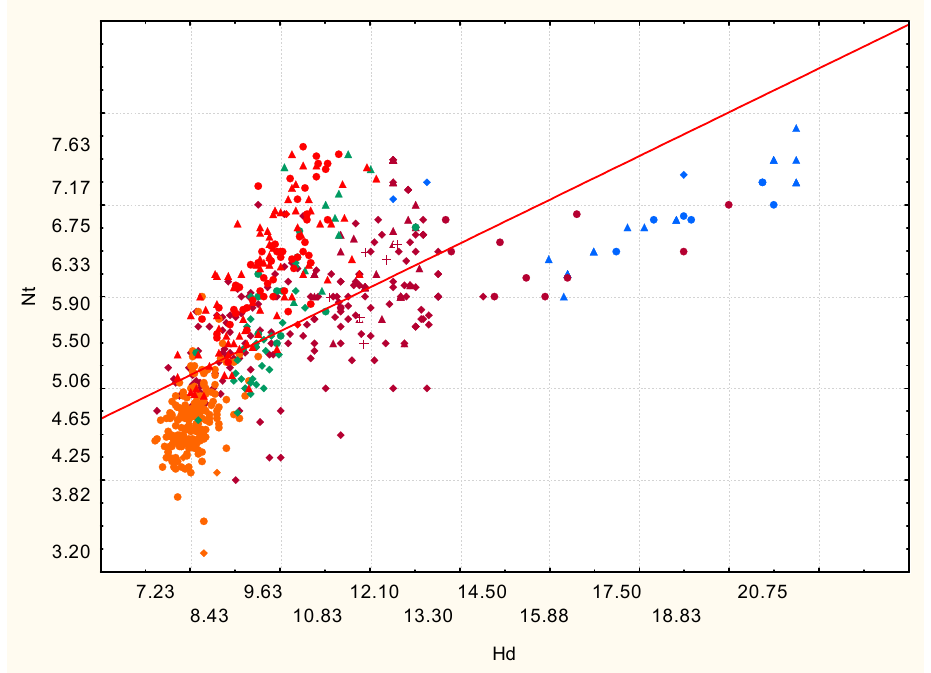
Figure 7. The ordination matrix of the distribution of syntaxons according to the factors of the water regime and the content of mineral nitrogen in the soil (Hd–Nt):